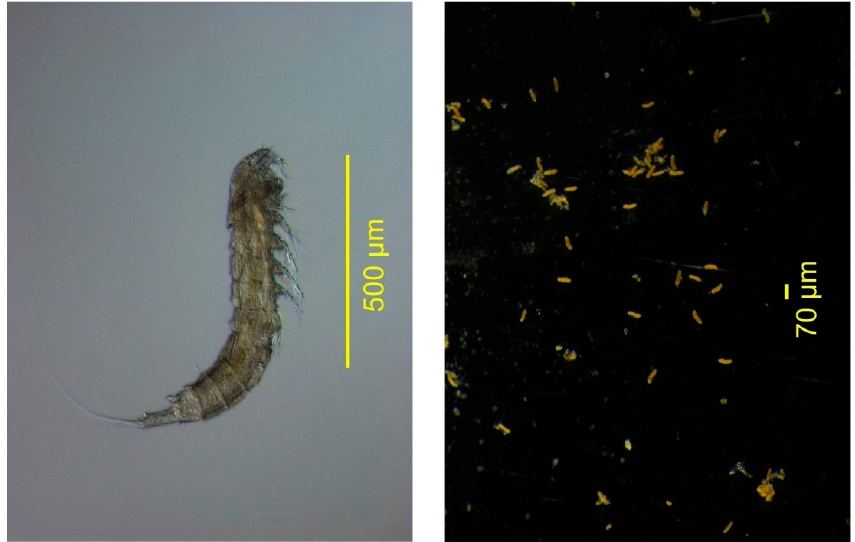
Figure 4. Adult female of Moraria sp. ( right ) and its fecal pellets ( left ). Moraria sp. shows stygobitic morphological traits such as lack of eyes, depigmentation, small body size, and long antennules and does not ingest the fecal pellets, which remain visible in the vial.